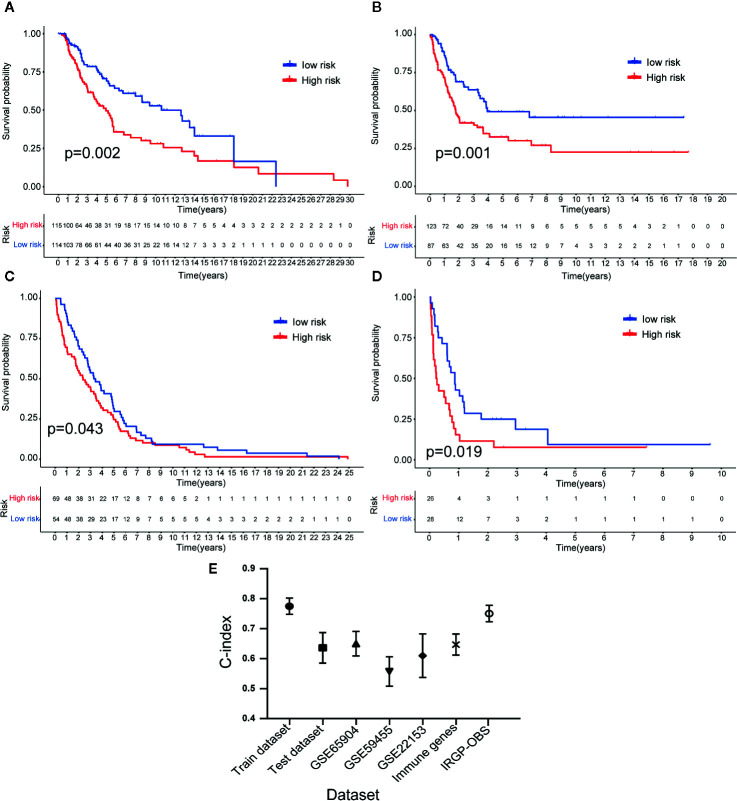
Validation of the 23-IRGP signature. As indicated, OS was poorer for the high-risk group than the low-risk group of the testing cohort (A). Datasets GES65904 (B), GSE59455 (C), and GSE54467 (D). These results showed that the 23-IRGP signature had good predictive ability (p < 0.05) (E). The C-index values for the TCGA training, testing cohorts and TCGA dataset, as well as the datasets GES65904, GSE59455, GSE54467, IRGs and IRGP-OBS were 0.775 (95% CI = 0.748–0.802), 0.636 (95% CI = 0.585–0.687), 0.691 (95% CI = 0.653–0.729), 0.650 (95% CI = 0.609–0.691), 0.557 (95% CI = 0.508–0.606), 0.610 (95% CI = 0.537–0.683), 0.647 (95% CI = 0.612–0.682), 0.751 (95% CI = 0.716–0.786), respectively.